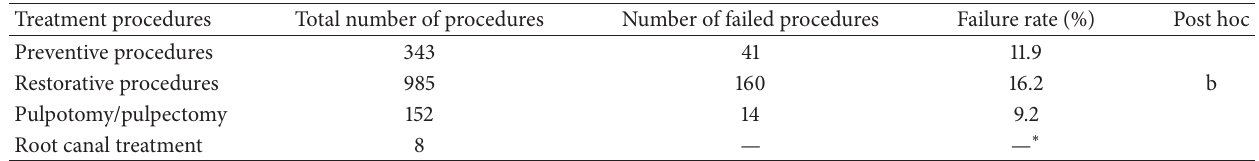
Table 1: Failures rates of different treatment procedures.